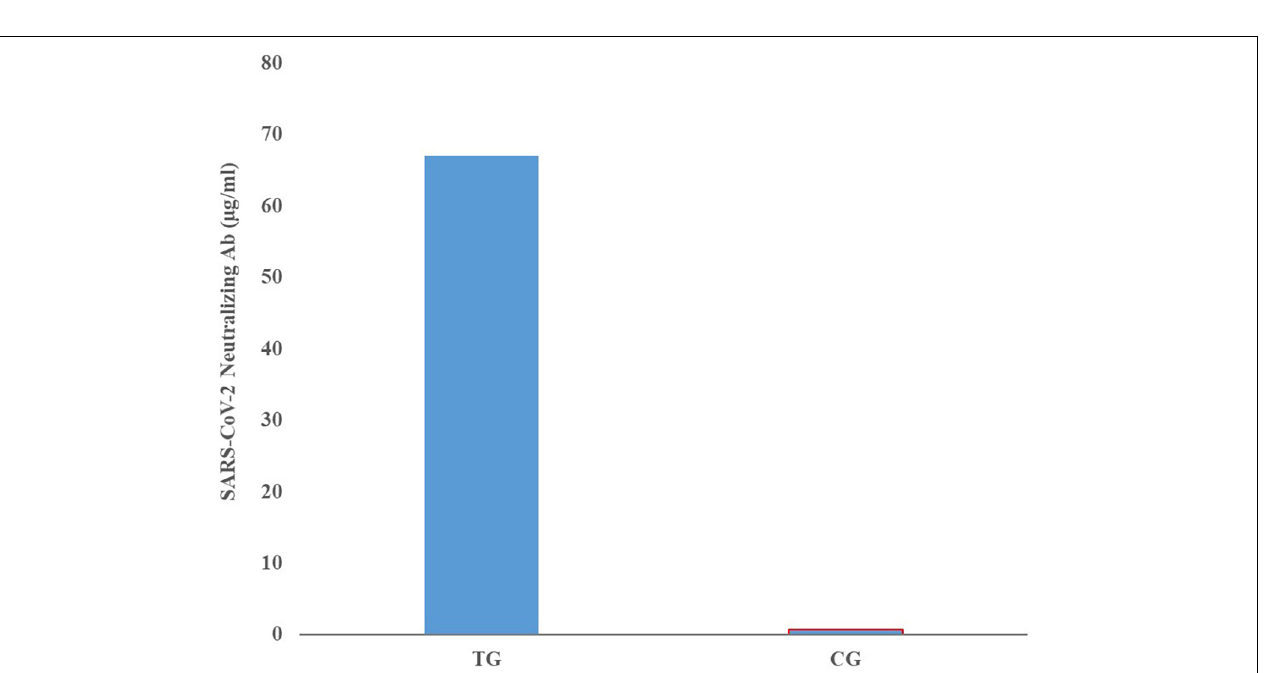
Frontiers in Nutrition |